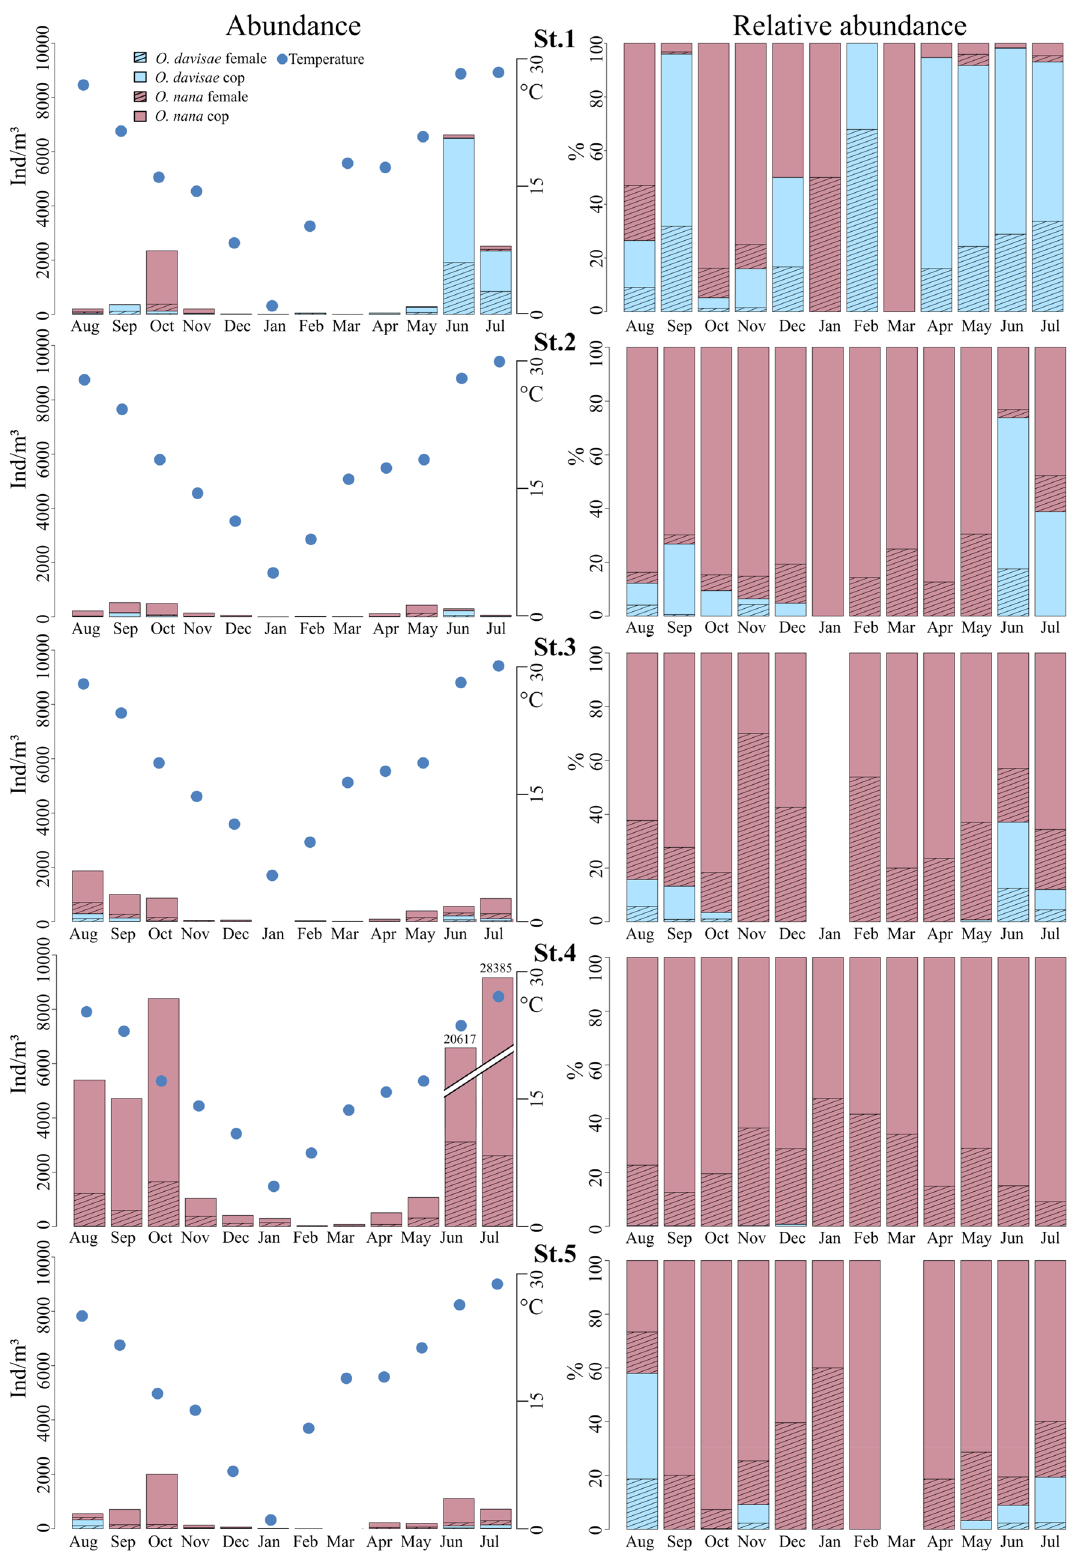
Figure 4. Absolute and relative abundance of copepodites and females of Oithona davisae and Oithona nana and temperature trends by station and